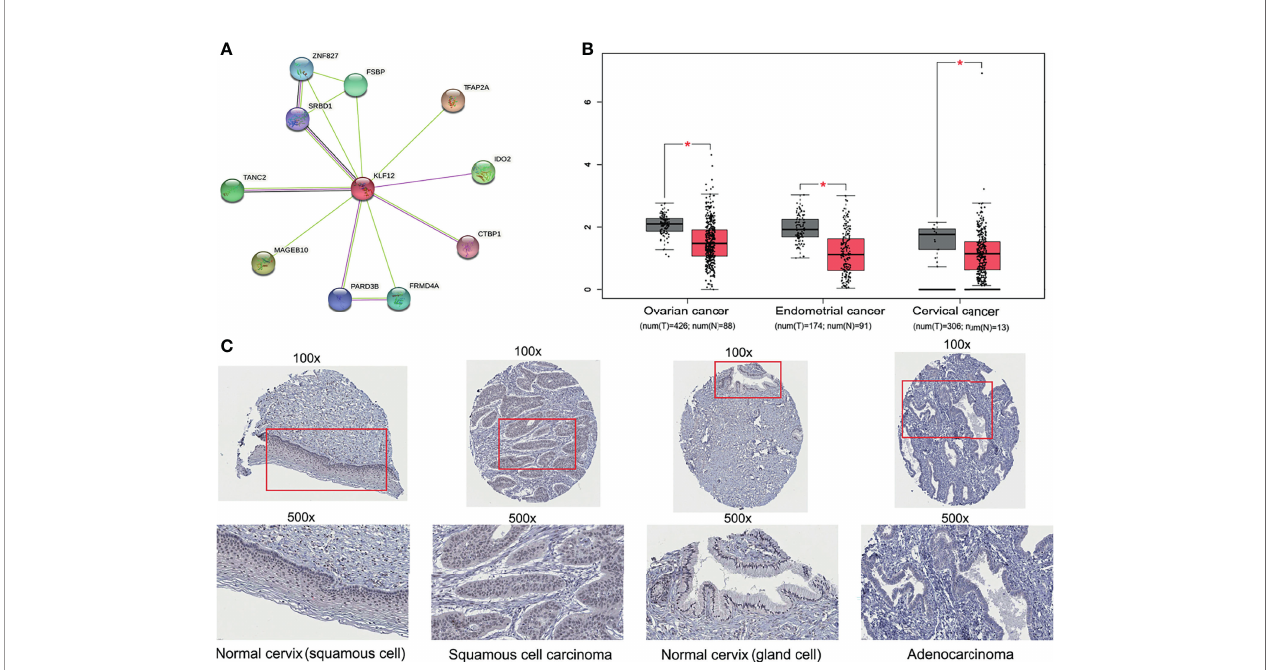
FIGURE 5 | Multi-database analysis for the function and expression of KLF12. (A) The protein – protein interaction (PPI) network of KLF12 was mapped based on the STRING database. The purple edges were described as experimentally determined known interactions, the light green edges meaning textmining and the black ones meaning ‘ co-expression ’ . The fi lled nodes mean their 3D structures are known or have been predicted, and the empty ones mean unknown. (B) The expression of KLF12 in gynecological tumors were shown based on the GEPIA and TCGA database. (C) Immunohistochemical results of KLF12 in normal cervix and cervical cancer from HPA database. *p <